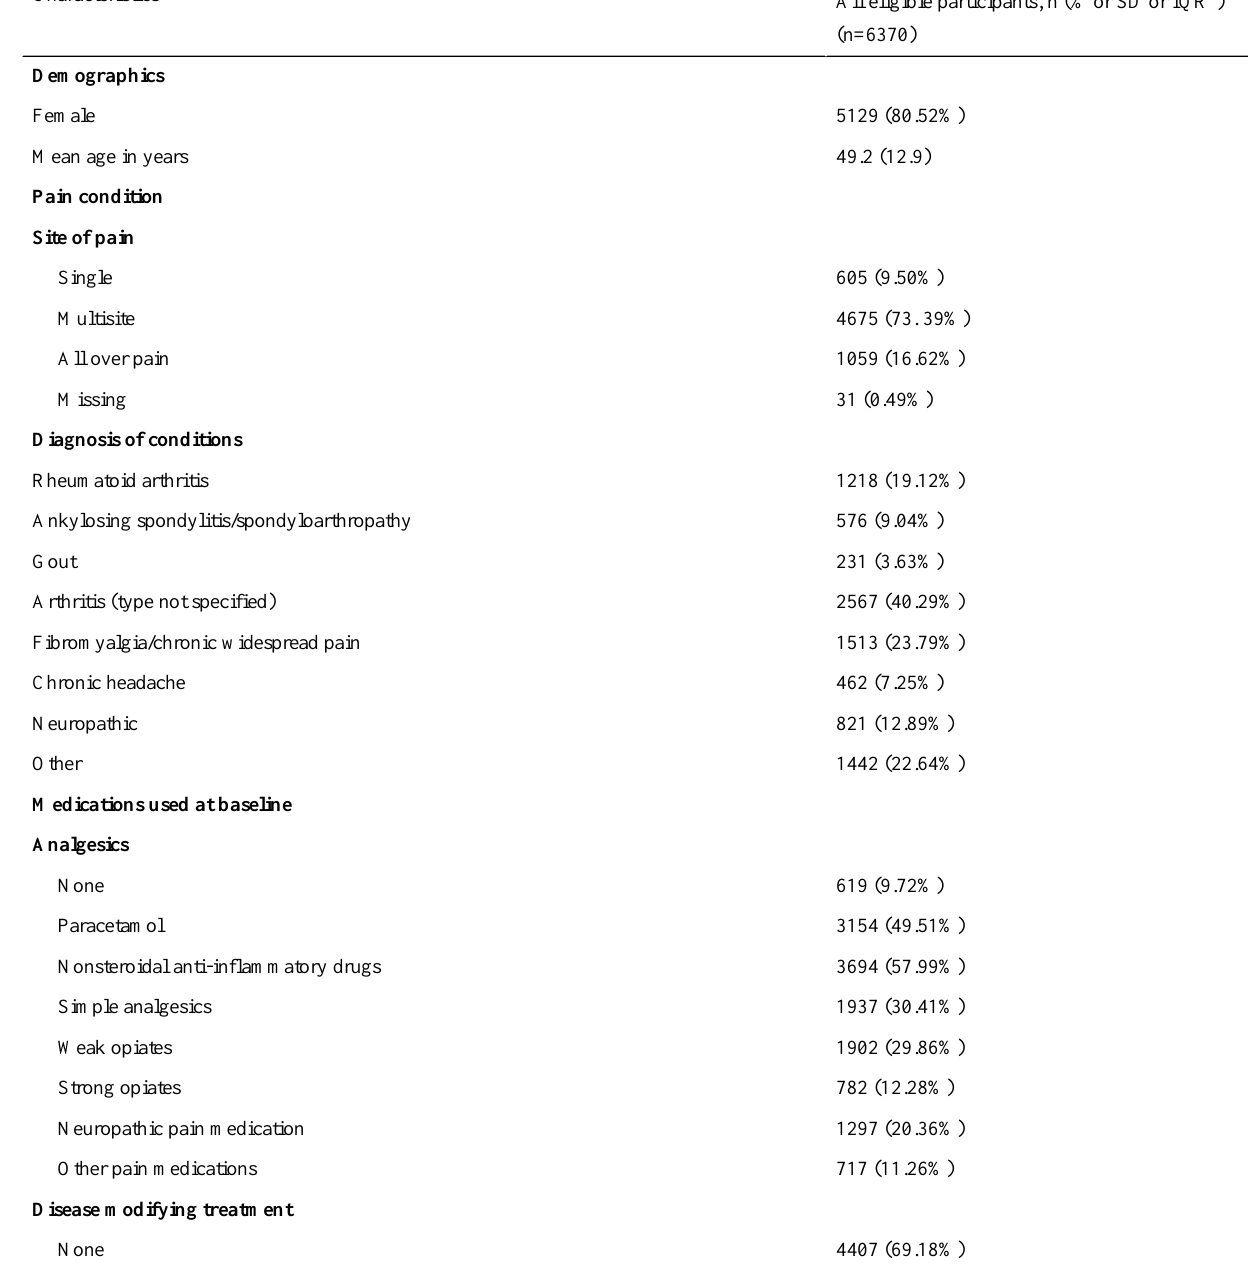
Table 1. Baseline characteristics of participants eligible for